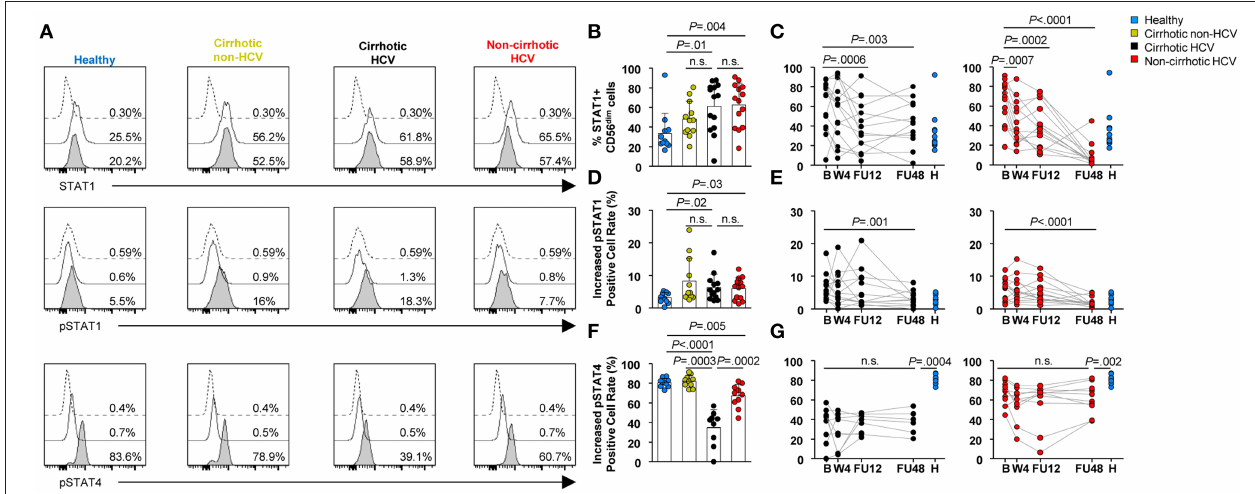
FIGURE 4 | Profound alterations in STAT1/4 activation in response to IFN- α in CD56 dim cells from HCV patients with cirrhosis. (A) Representative histograms of a healthy subject, non-HCV cirrhotic control, HCV cirrhotic, and non-cirrhotic patients are shown. Dotted lines show staining of cells with isotype control; thick lines show staining of unstimulated cells; and thick lines with shaded areas show staining of IFN-stimulated cells. Comparison of baseline frequencies and longitudinal analysis of STAT1 + CD56 dim cells (B,C) , pSTAT1 (D,E) , and pSTAT4 (F,G) levels in response to IFN- α between healthy controls, non-HCV cirrhotic controls, cirrhotic HCV, and non-cirrhotic HCV patients. Increased positive cell rates were determined by subtracting the positive cell rate of unstimulated cells from that of stimulated cells. Error bars indicate mean + SD; P -values at baseline were determined by Mann–Whitney U test; P -values during longitudinal analysis were determined by mixed models for repeated measurements. n.s., not